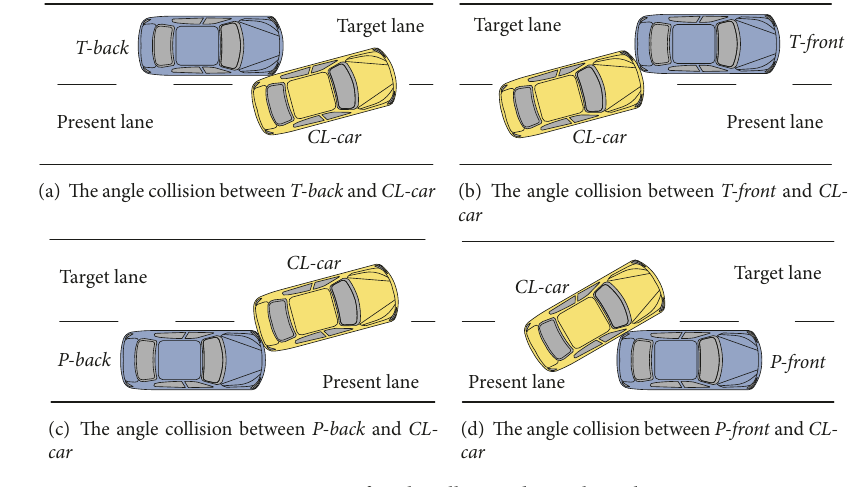
Figure 2: Scenes of angle collisions during lane change.